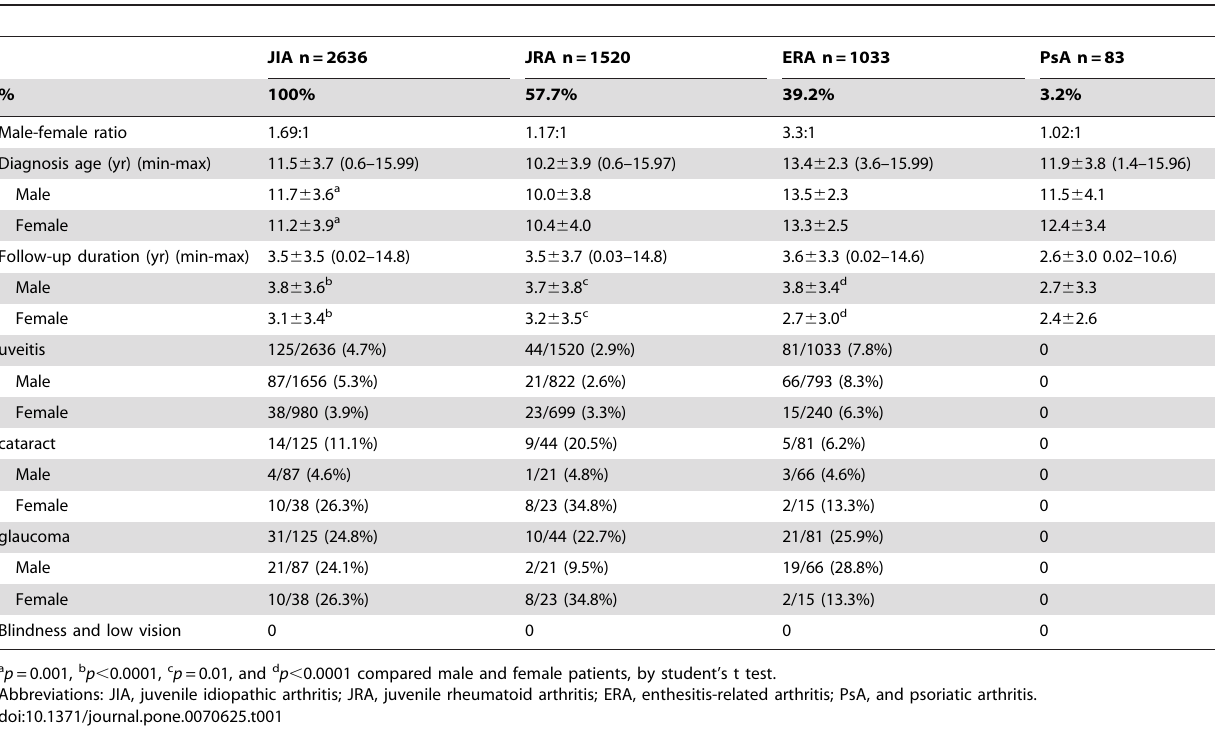
Table 1. Demographic data of patients with JIA.